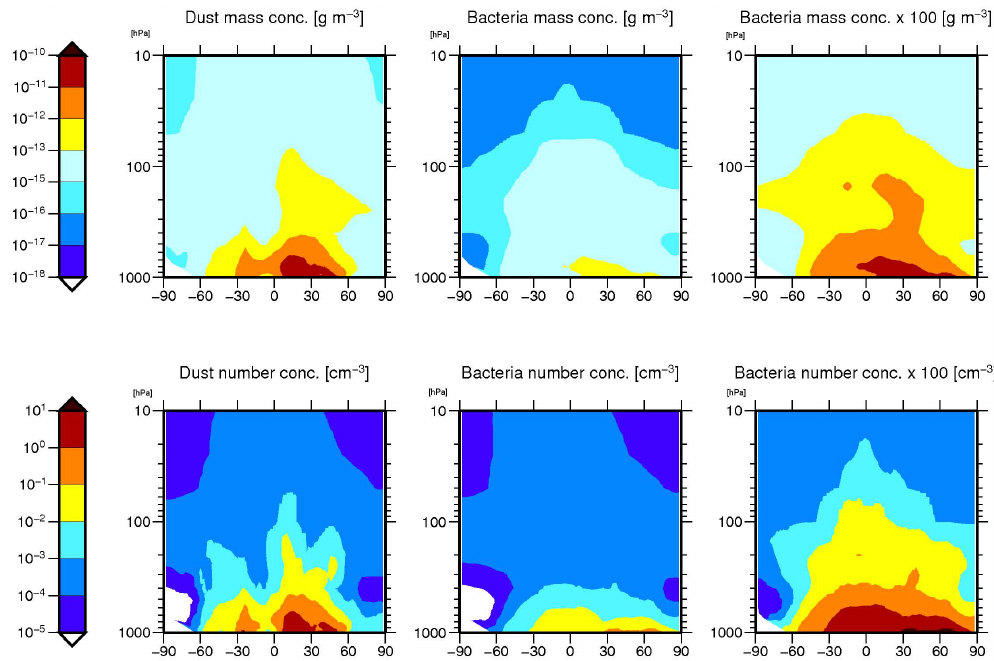
Fig. 2. Modelled (CTL and 100BT100, see Table 1 for description) annual zonal mean vertical profiles of dust and bacteria mass [gm − 3 ] and number concentrations in [cm − 3 ].